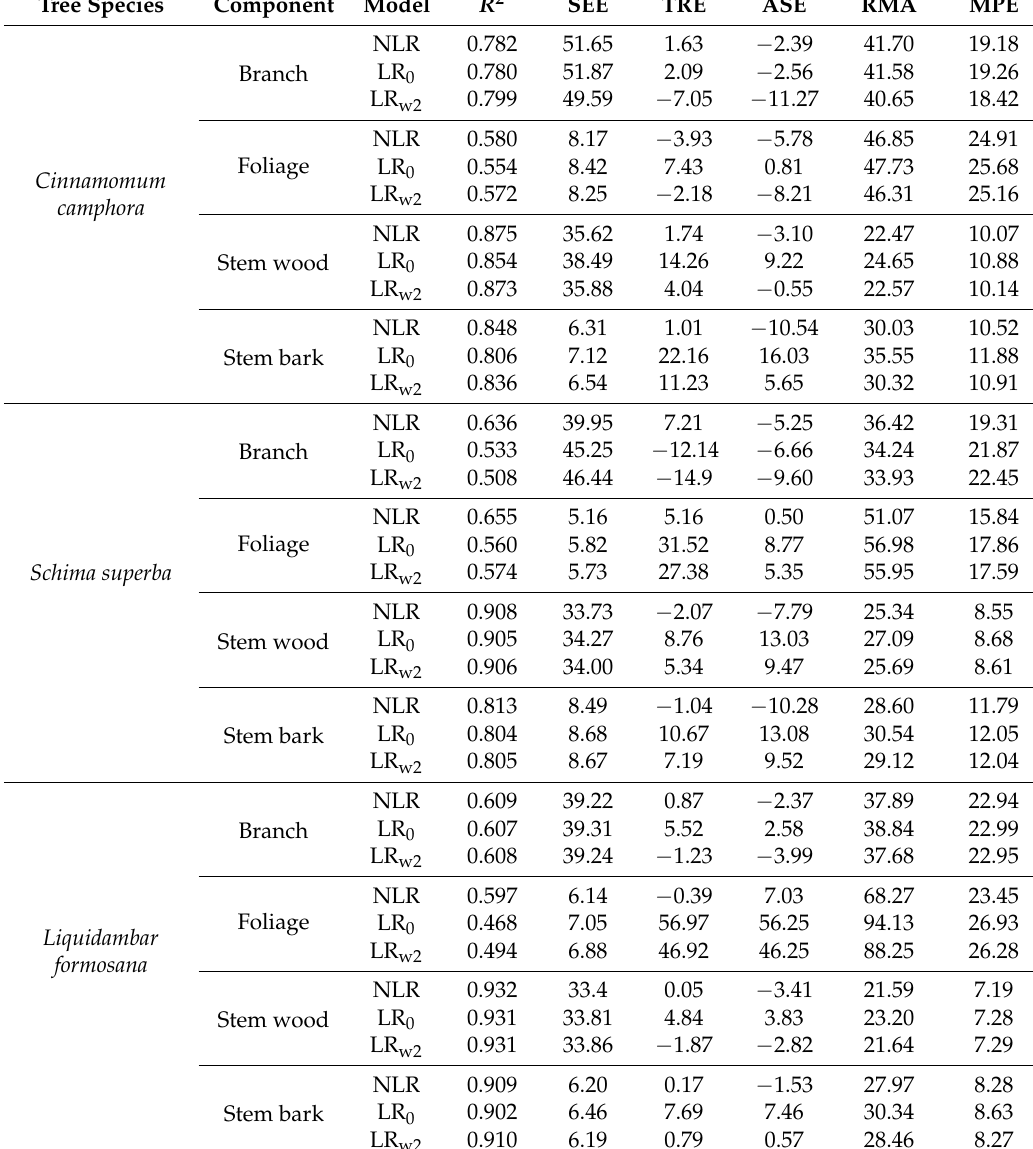
Table 5. Evaluation statistics for each component equation from nonlinear model (NLR), uncorrected linear model (LR 0 ) and linear model corrected by CF w2 (LR w2 ) for three tree